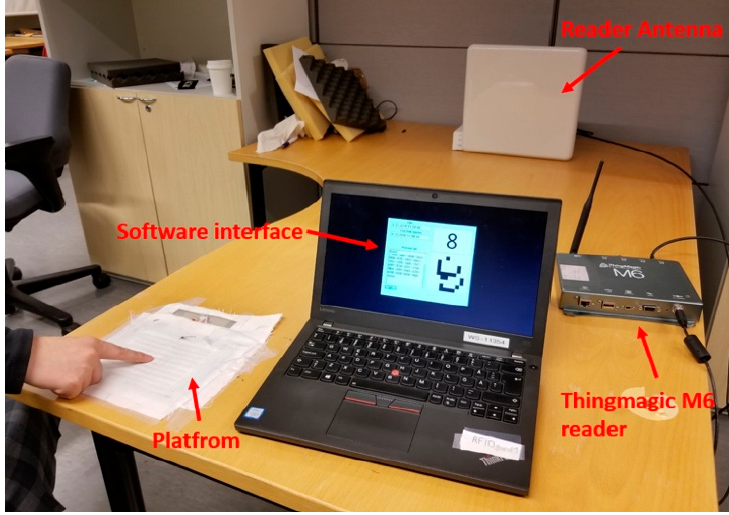
Figure 7. Real-time testing in a normal office environment.